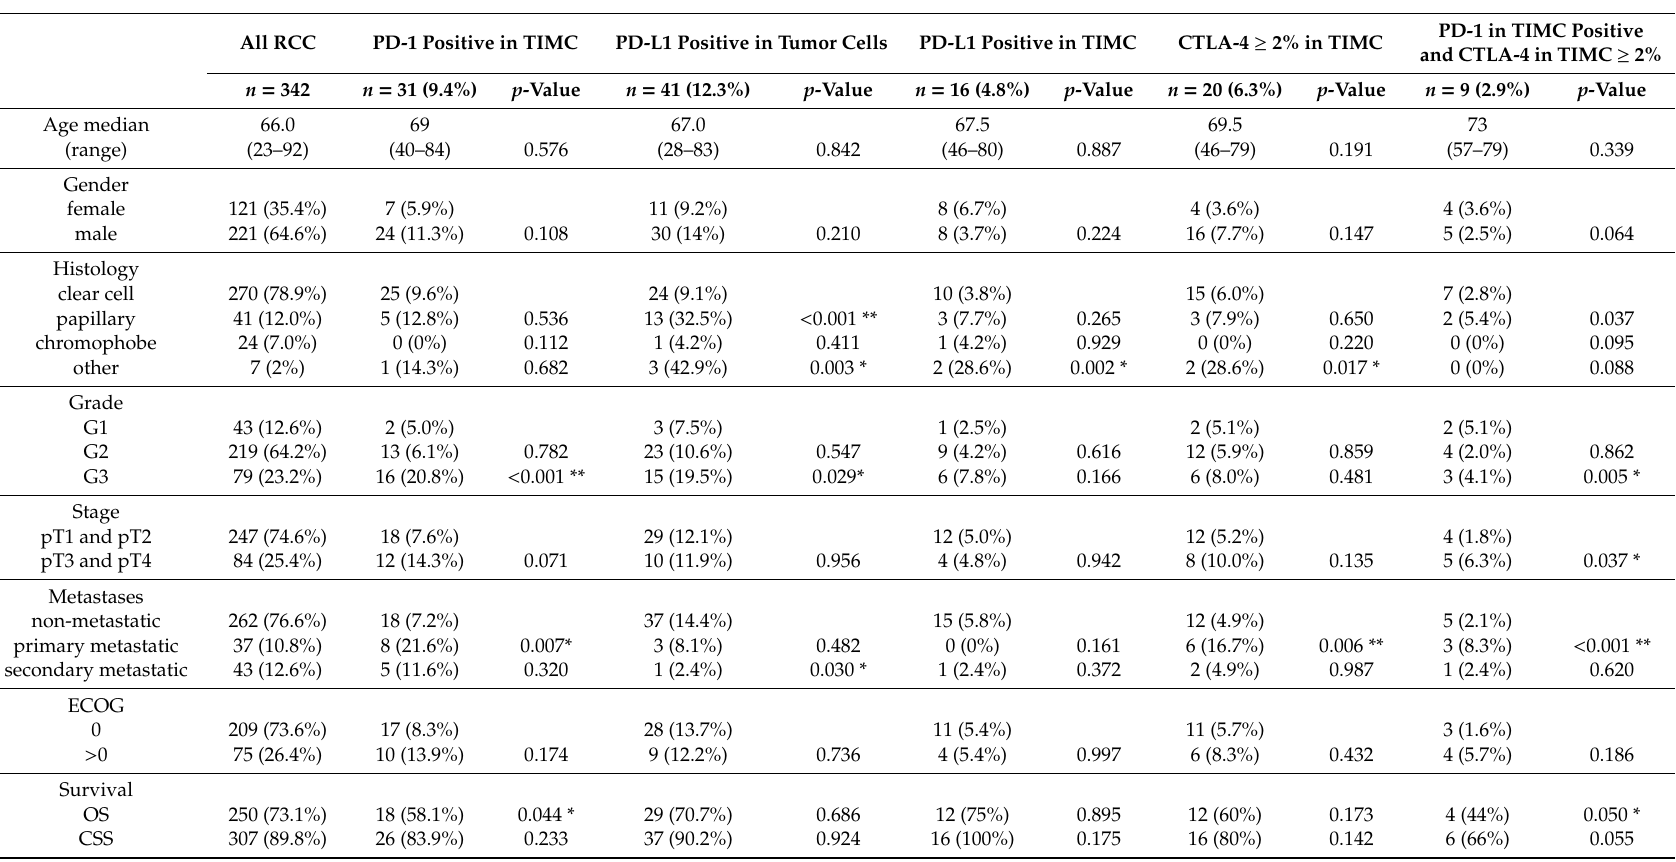
Table 1. Patient characteristics and protein expression of immunological